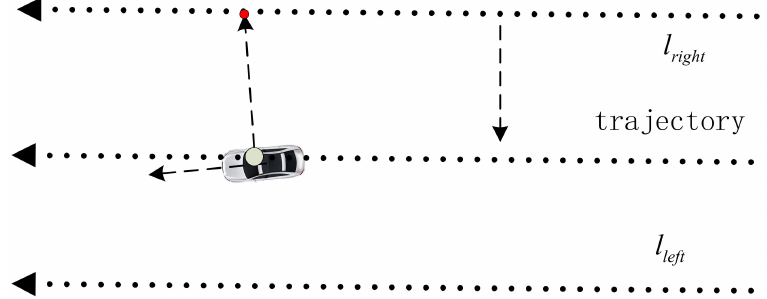
Figure 5. Recalculation of positioning information combined with map